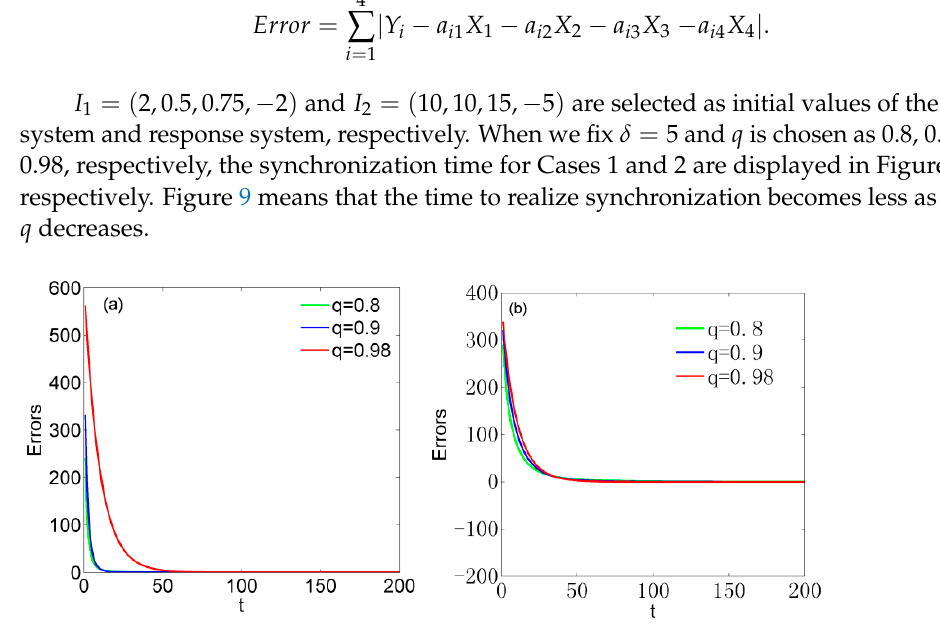
Figure 8. Synchronization plots of the generalized linear synchronization. ( a )